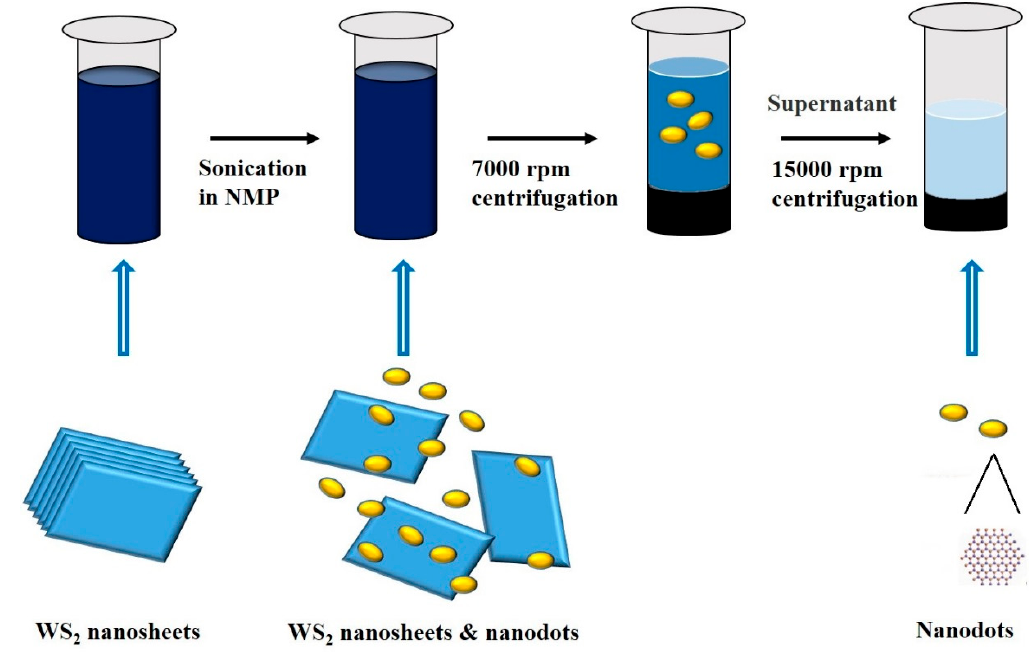
Figure 1. Synthesis process of WS 2 QDs (Quantum dots), including an ice-bath sonication and two-step centrifugation.